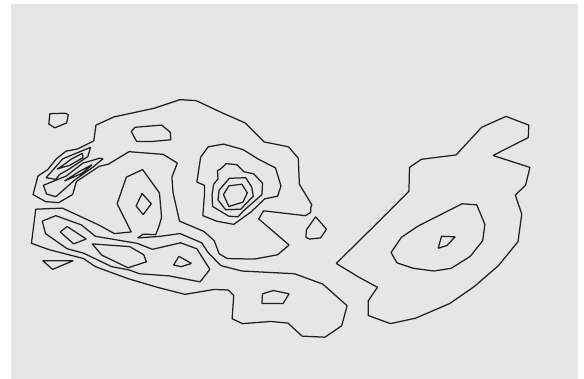
Figure 18: Experimental flow around island, surface vorticity field.